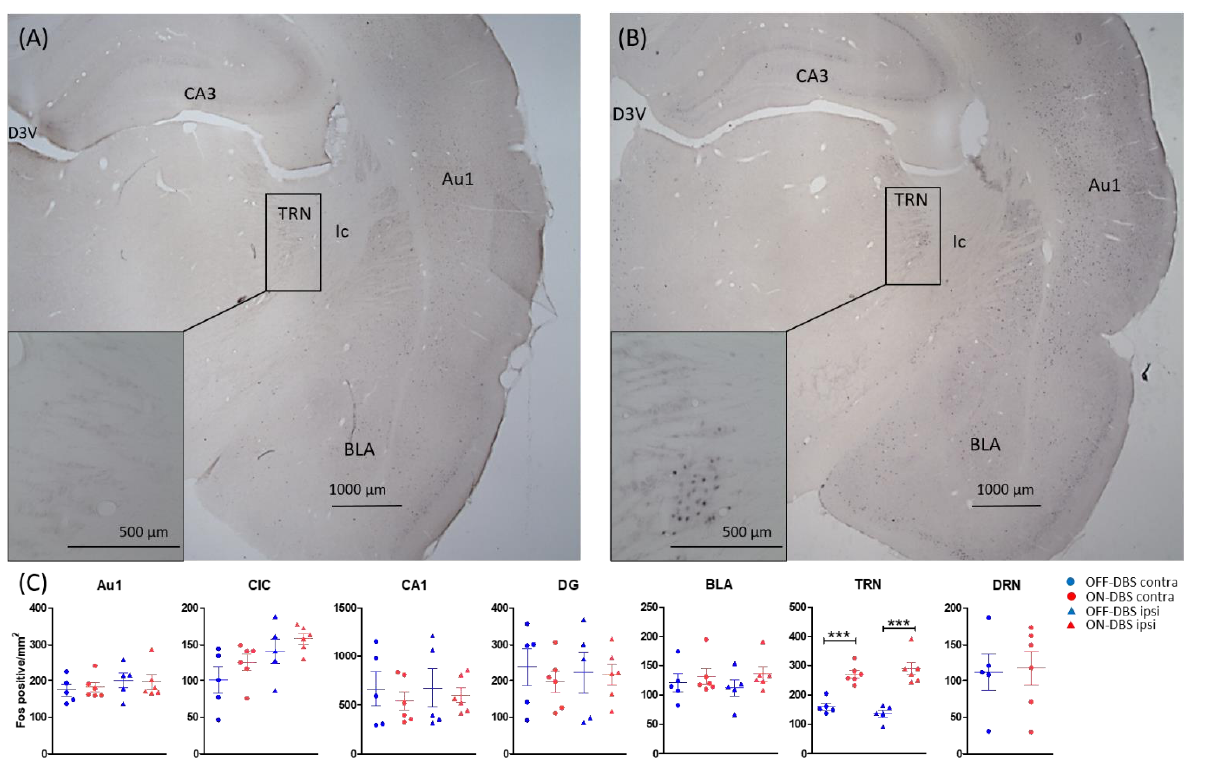
Figure 2. Representative photomicrographs were taken of rat brain sections containing the thalamic reticular nucleus (TRN) in OFF DBS and ON DBS conditions ( A , B , respectively). The sections were immunohistochemically stained using an antibody raised against c-Fos. ( C ) The graphs show the cumulative data of the means and SEMs of c-Fos-positive cells in ON DBS and OFF DBS groups on the ipsilateral and contralateral sides to noise trauma. Note that only TRN showed a significant increase in c-Fos expression in the ON DBS group. p values < 0.05 were defined as significant, and *** represents p ≤ 0.001. Scale bar = 1000 and 500 in the overview and zoomed box, respectively. Abbreviations: Au1, primary auditory cortex; BLA, basolateral amygdala; CIC, the central part of inferior colliculus; D3V, dorsal third ventricle; DG, dentate gyrus; DRN, dorsal raphe nucleus; Ic, internal capsule; TRN, thalamic reticular nucleus.